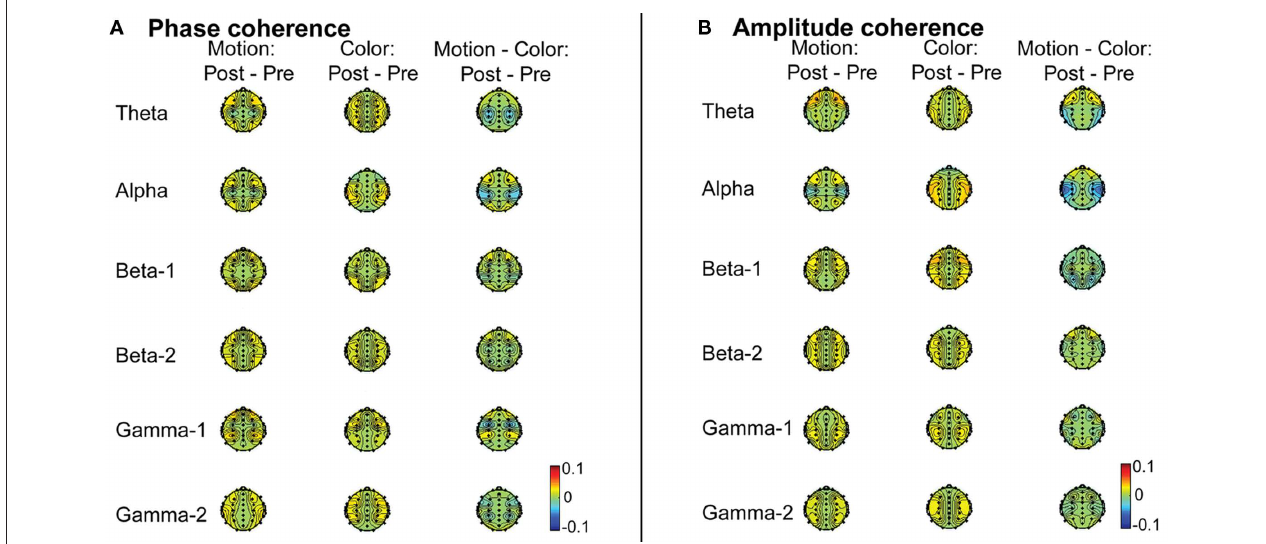
difference topographic head maps of amplitude coherence values in theta (4–7 Hz), alpha (8–13 Hz), lower beta (14–21 Hz), higher beta (22–33 Hz), lower gamma (36–44 Hz), and higher gamma (44–90 Hz) frequency bands averaged across the 4-min baseline recording periods before and after the EM vs. the control manipulation (average-reference data). The magnitude of cross-channel coherence varies between 0 and 1, with 0 indicating a complete absence of synchronization and 1 indicating perfect synchronization. Colors here denote changes in coherence, with yellow–red (positive values) denoting increased coherence, and green–blue (negative values) denoting decreased